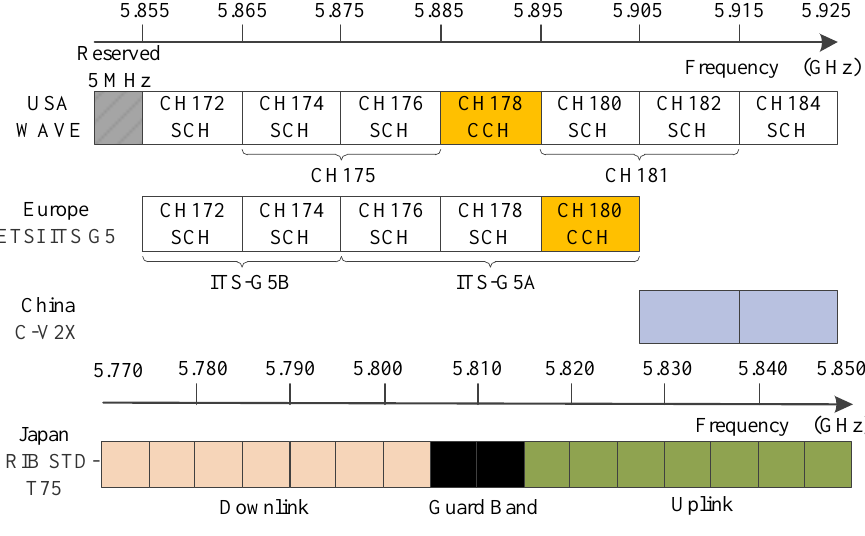
Figure 3. Spectrum allocation for VANETs.